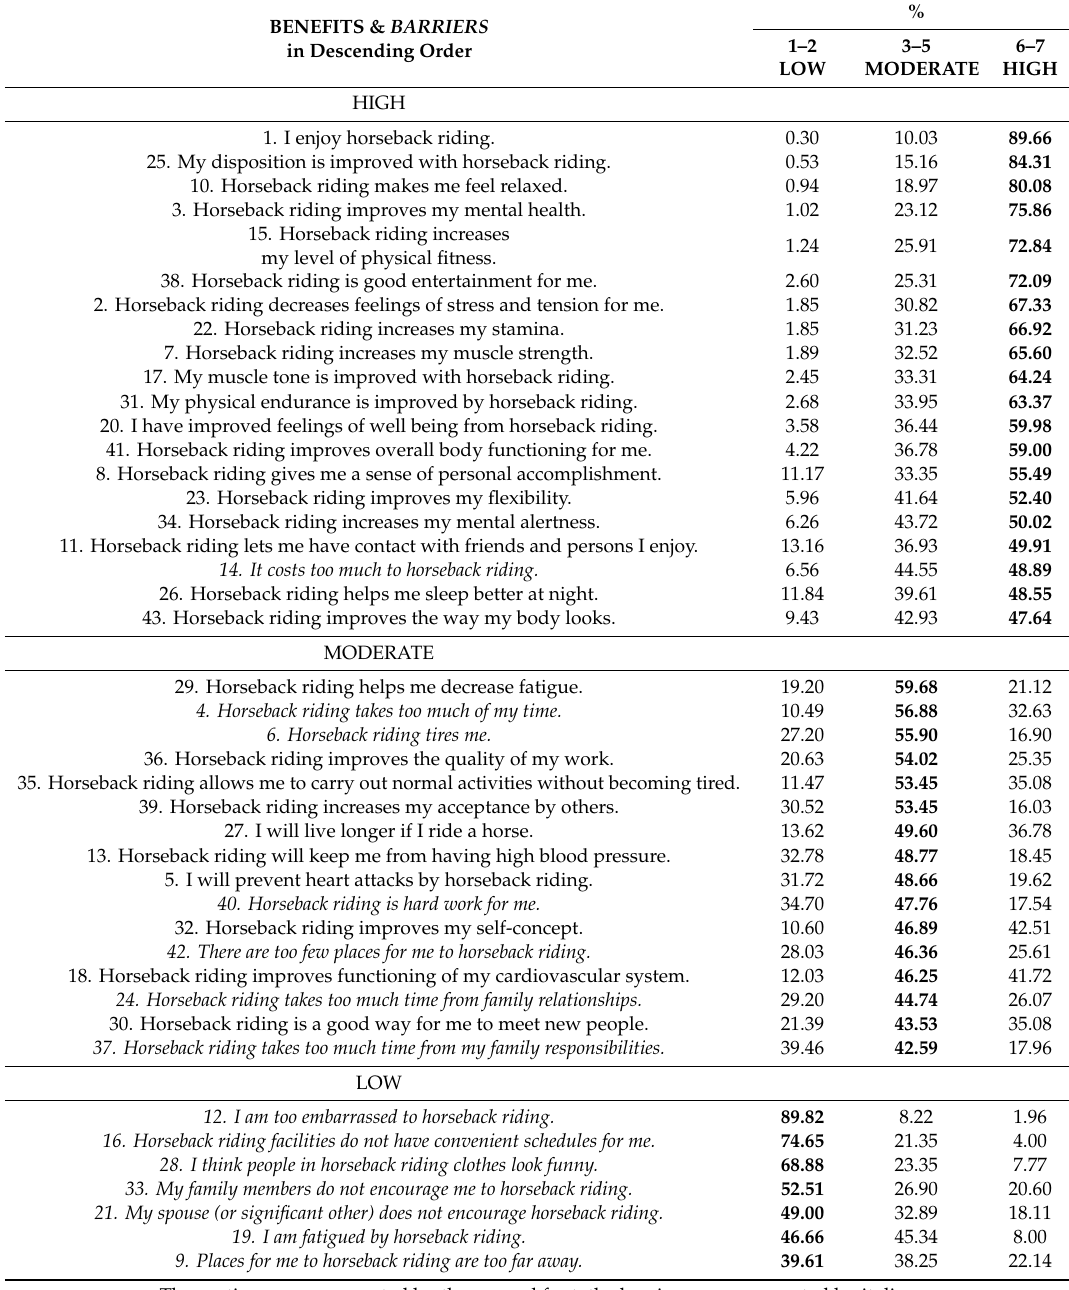
Table 3. The percentage distribution of answers given by all respondents (n = 2651) in the range 1–7 Likert scale (1—this issue concerns me to a very low degree; 7—this issue concerns me to a very high degree) divided in 3 groups, with low, moderate, and high